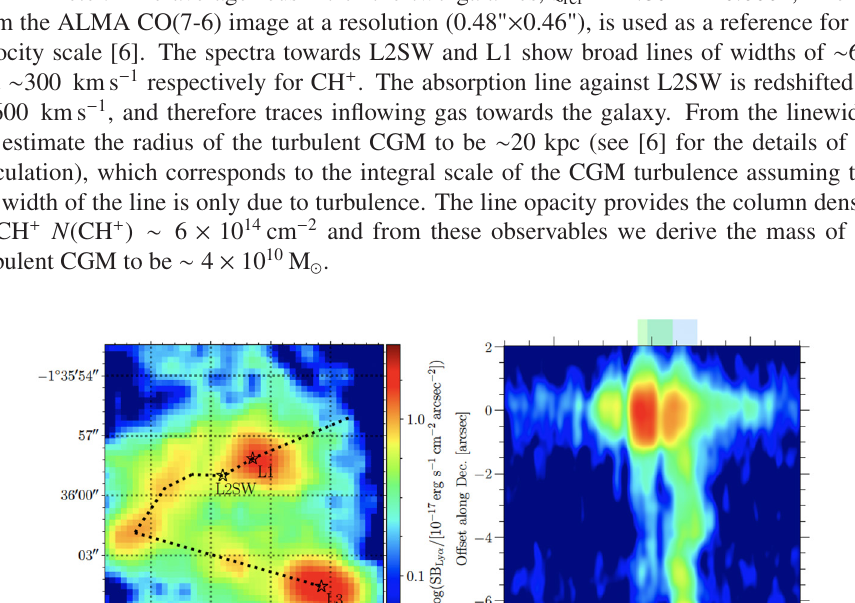
absorption lines which are indicated by the shaded